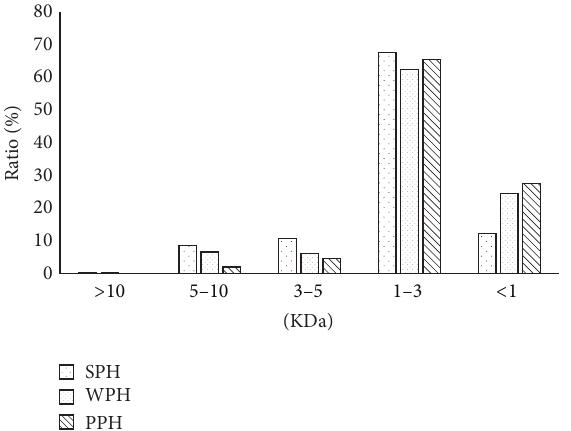
Figure 1: The molecular weight distribution of peptides from SPH, WPH, and